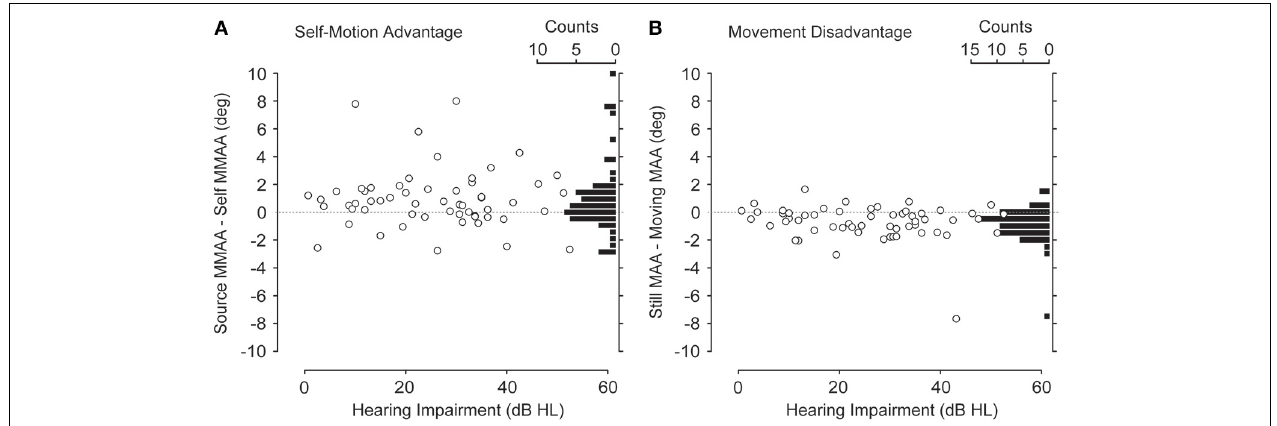
FIGURE 6 | (A) Self-motion advantage. The open circles are the MMAAs measured during self motion subtracted from the MMAAs measured during source motion. The histograms to the right are binned data. The majority of points fall above the zero difference line (dotted line). (B) Movement